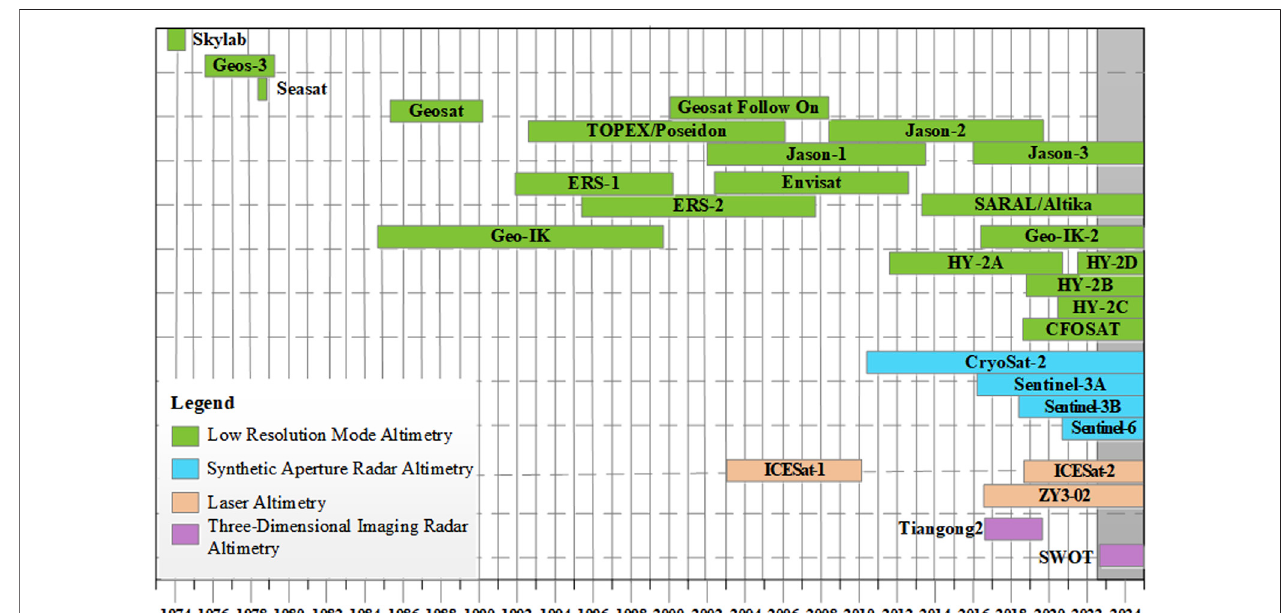
FIGURE 1 | Overview of satellite altimetry